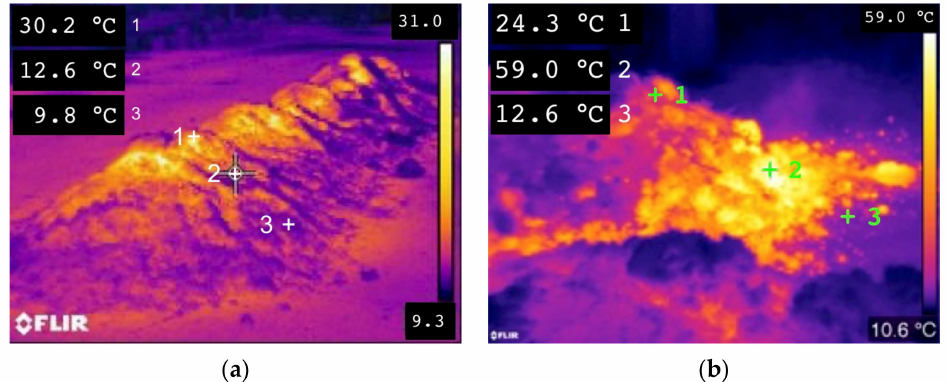
Figure 6. Thermal images acquired at day 40. Outside temperature profile ( a ); inside temperature profile ( b